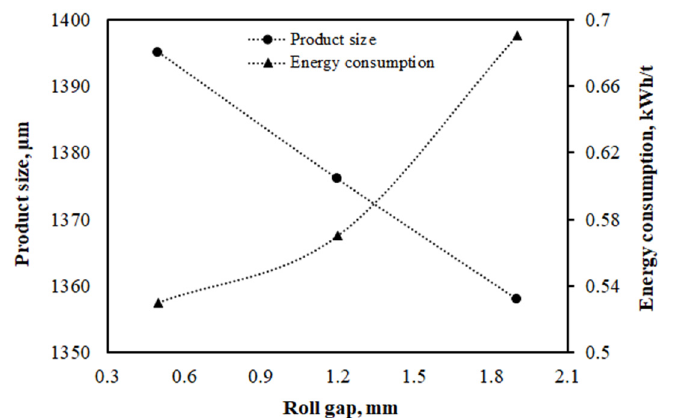
Figure 4. Effect of the gap between the rolls on product size and energy consumption at 12 kN applied load and 650 Rpm roller speed.